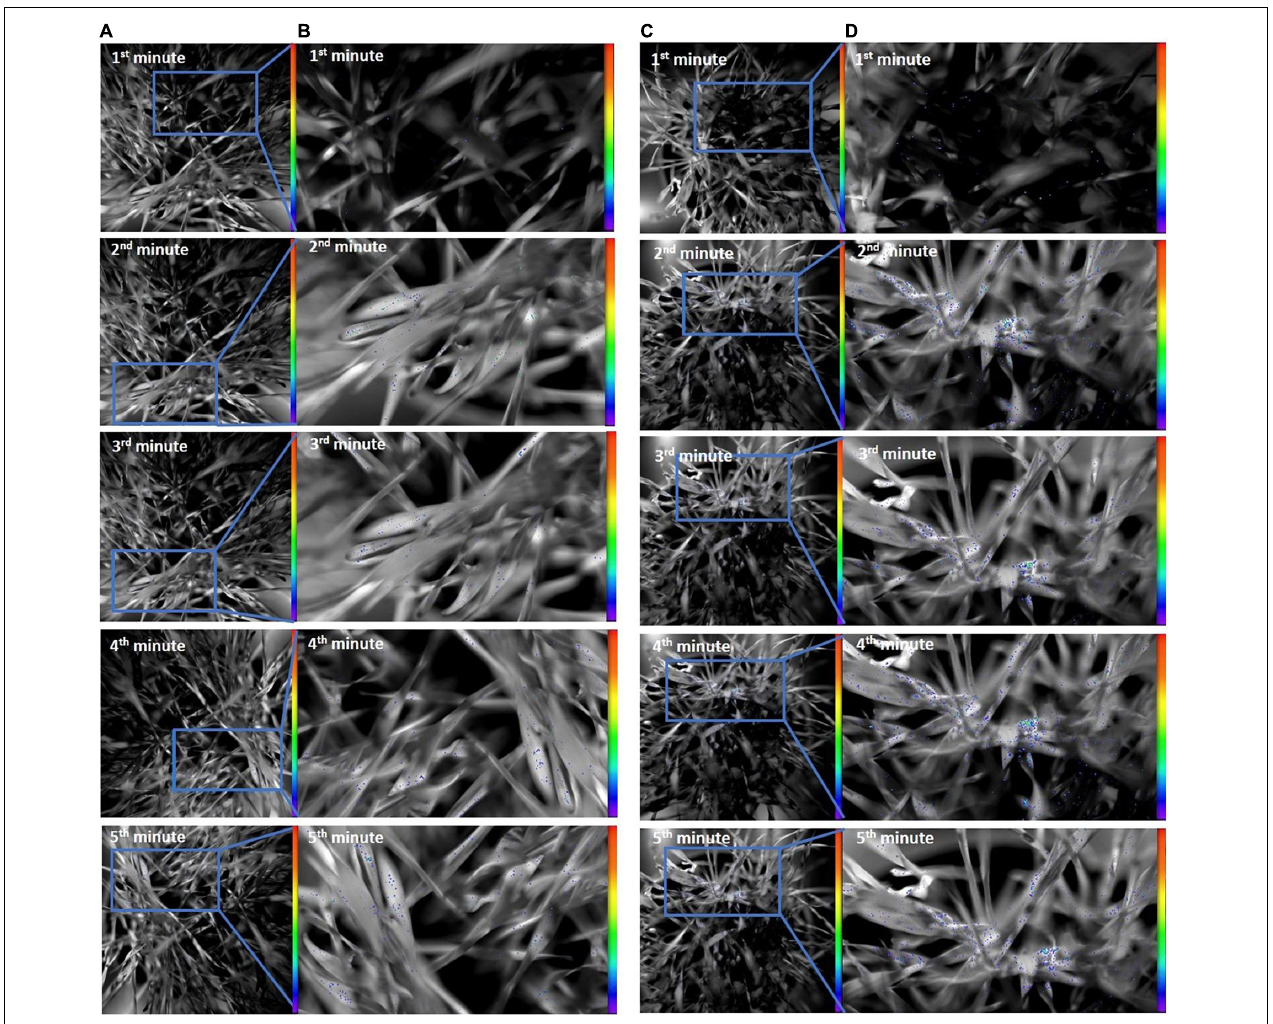
FIGURE 5 | Ultra-weak photon emission of ( A : original; B : enlarged) healthy and ( C: original; D: enlarged) O. melanopus -infested leaves during the first 5 min of measurement. The intensity of color bar shows signal intensity detected by the equipment and converted into a scale of color intensity via IndiGoTM 2.0.5.0.